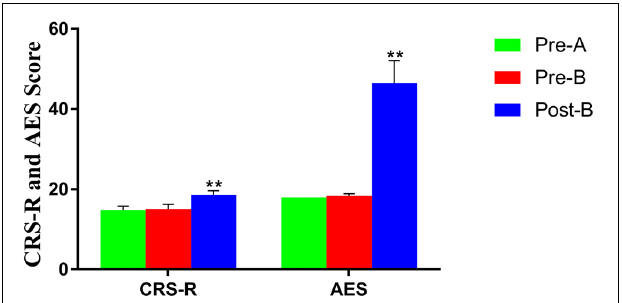
FIGURE 2 | Altered CRS-R and AES in patients before and after treatments. **Significant p -value: p < 0.01. The results showed that CRS-R and AES were improved significantly after